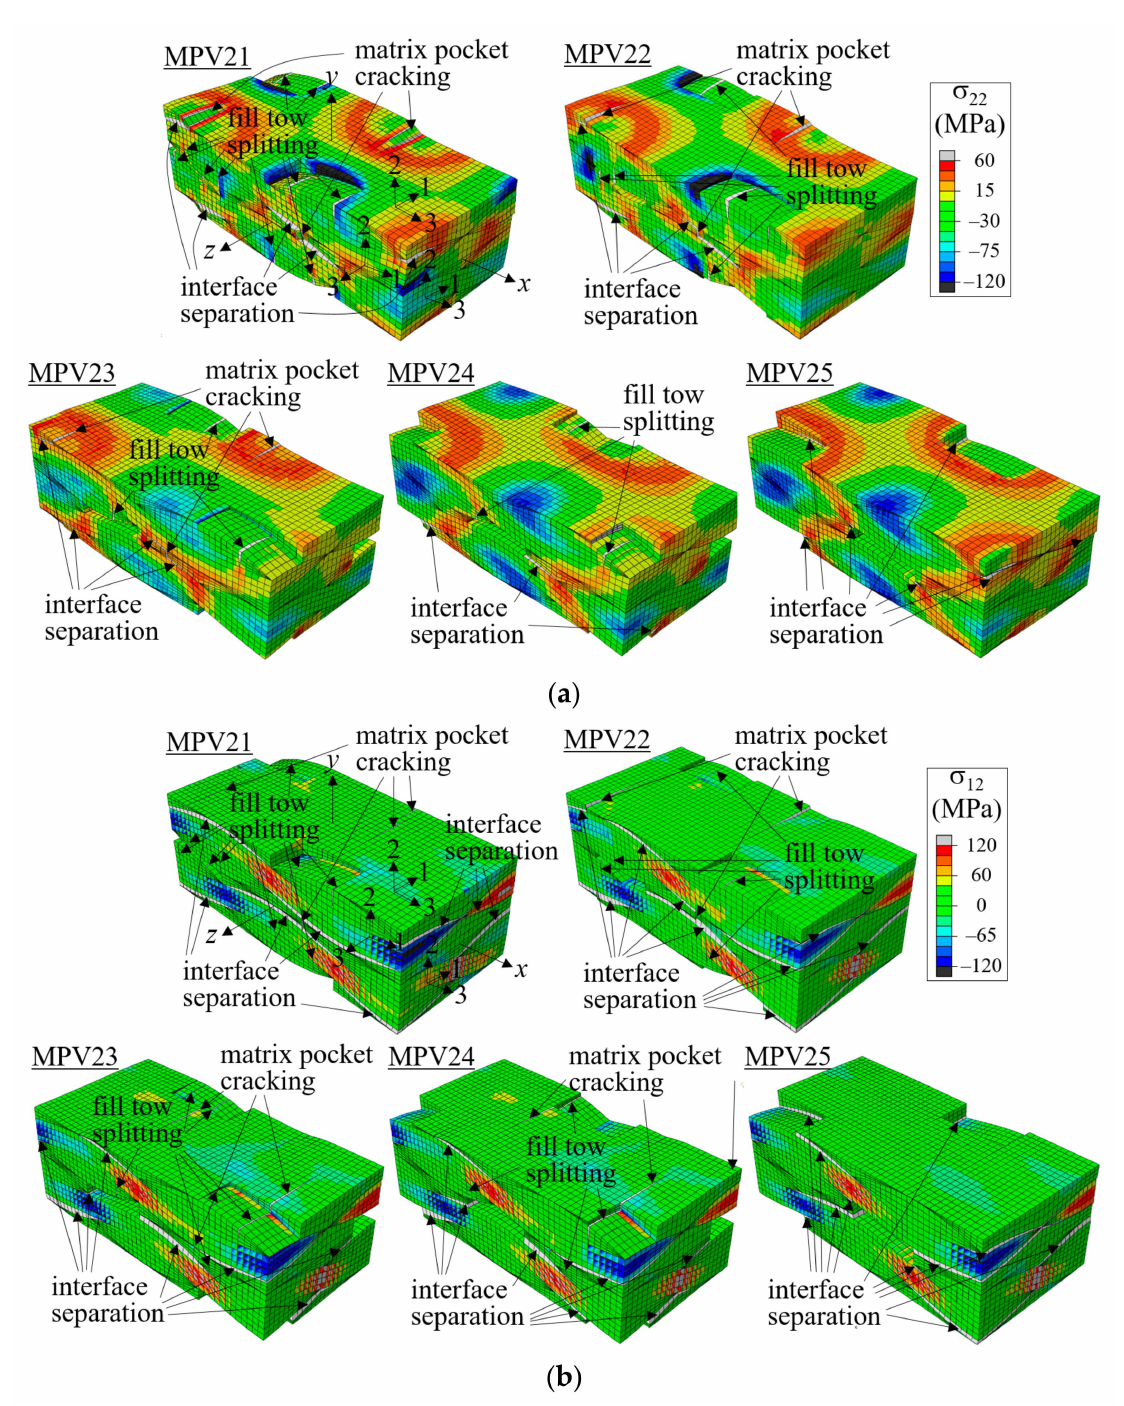
Figure 25. Failure development of two-ply shifted model with MPV defect: ( a ) σ 22 stress distribution at ˆ ε xx = 0.00969 (deformation scale factor = 5); and ( b ) σ 12 stress distribution at ˆ ε xx = 0.0138 for MPV21,23-25 and ˆ ε xx = 0.015 for MPV22 (deformation scale factor =